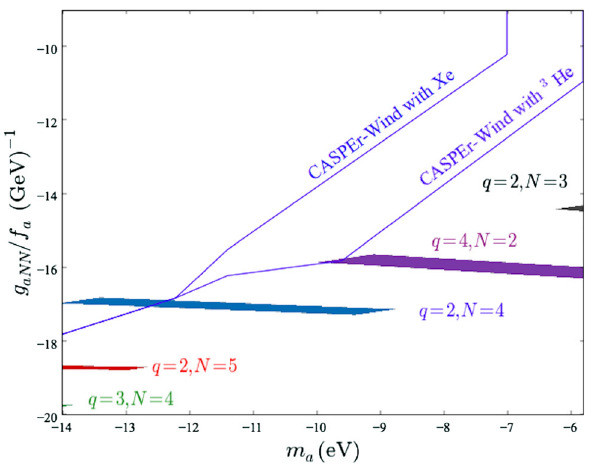
Fig. 5 Sensitivity of CASPEr-Wind to the ALPs (colored regions indi- cate axions suitable to saturate the DM relic density, blue curves set the limit of the upper left part of the plot where the sensitivity of CASPEr- Wind allows for a DM detection. Both axes are